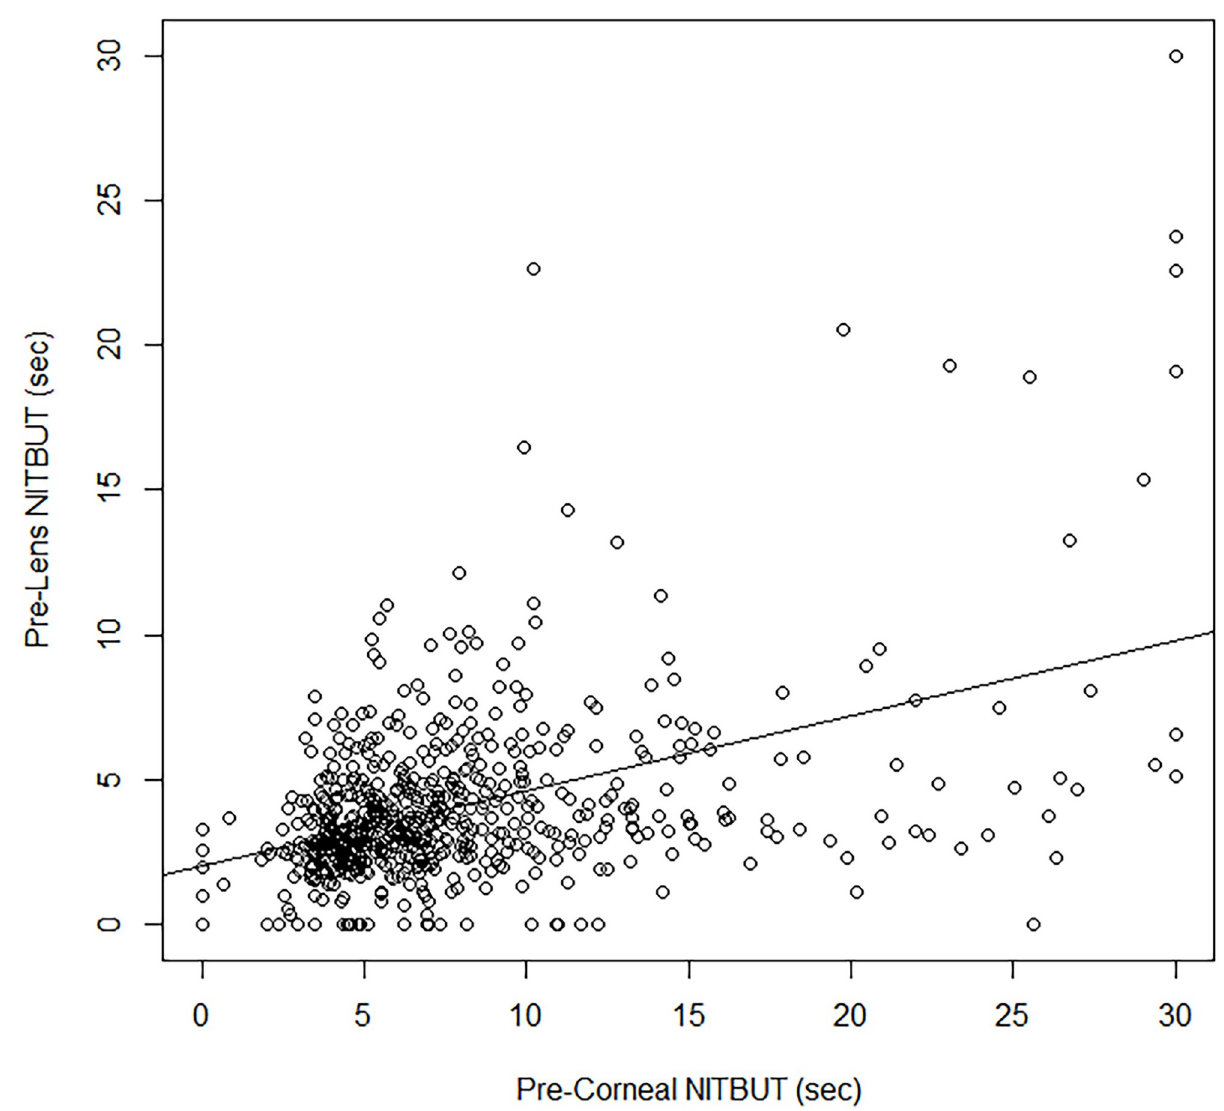
Fig 4. Pre-corneal vs. pre-lens NITBUT at 2–6 hrs post-contact lens insertion (n = 647).